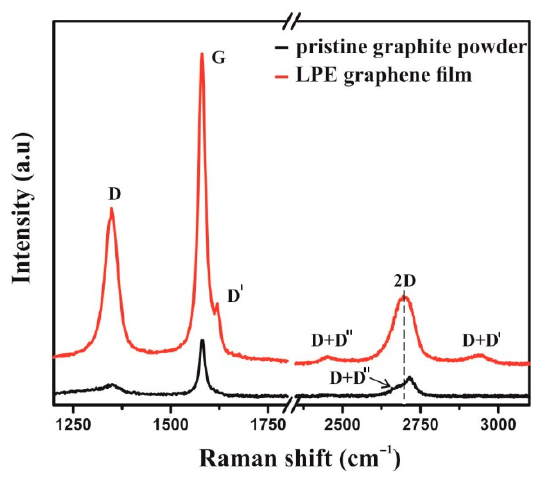
Figure 4. Raman spectrum of LPE graphene film (red line) and pristine graphite powder (black line).